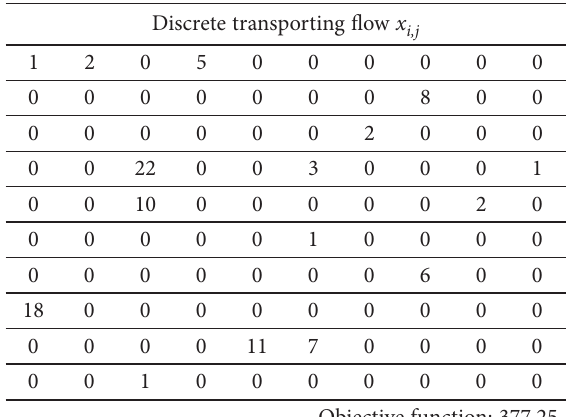
Table 11. Best obtained discrete solution for the 10×10 test problem with cost function